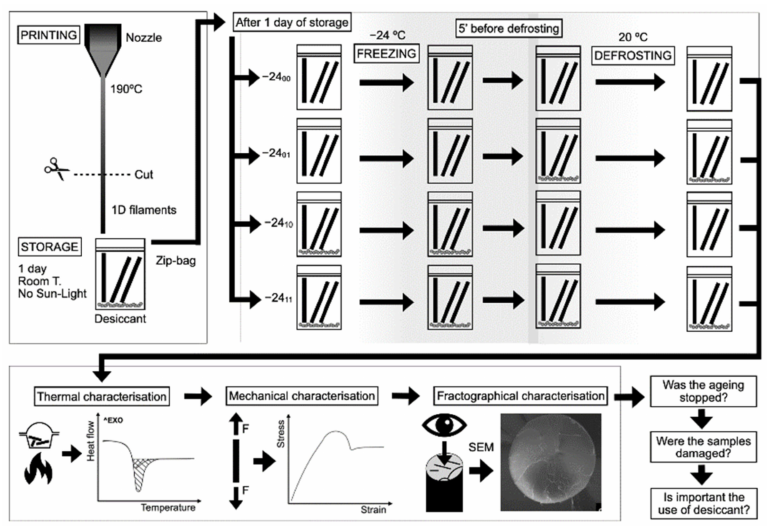
Figure 1. Summary of the materials and methods: material preparation, anti-ageing process, thermal, mechanical and fractographical